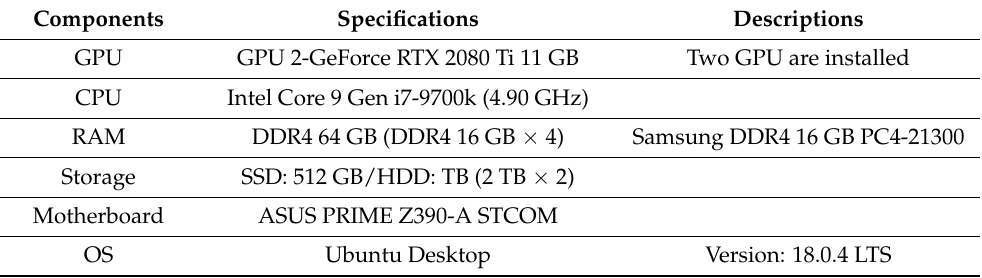
Table 3. The hardware and software specification of the AI server. Components